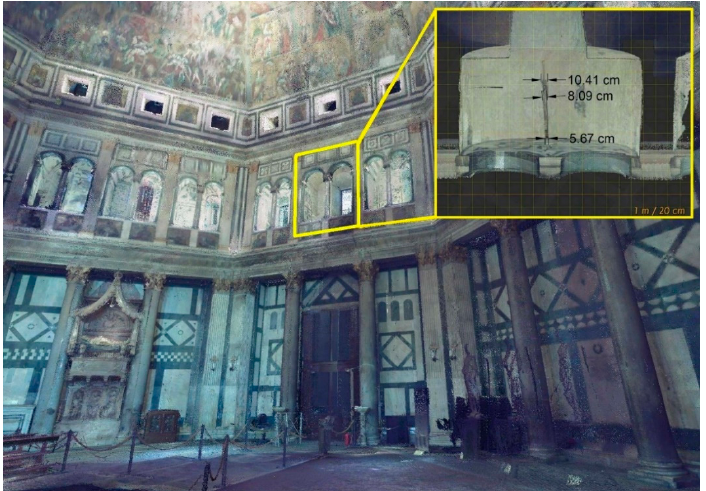
Figure 6. Scanning data highlighting the dimensions of a crack above the north door of the Baptistery di San Giovanni in Florence. Source: [29]. Figure 12, page